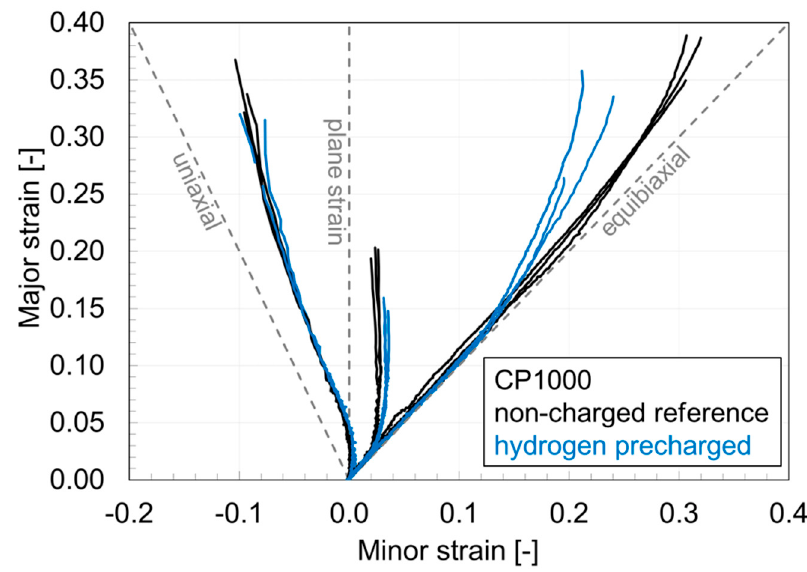
Figure 10. Strain paths (major strain plotted versus minor strain) of the point with maximal strain in the localized zone determined by DIC.